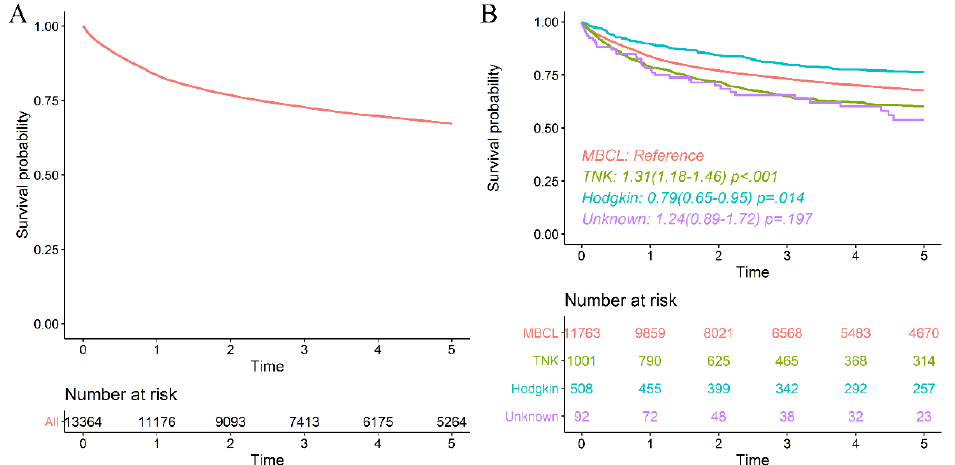
Figure 2. Survival rate of malignant lymphoma patients with chronic hepatitis B virus. ( A ). Overall survival of malignant lymphoma with chronic hepatitis B virus. ( B ). Survival rate of malignant lymphoma with chronic hepatitis B classified by subtype.